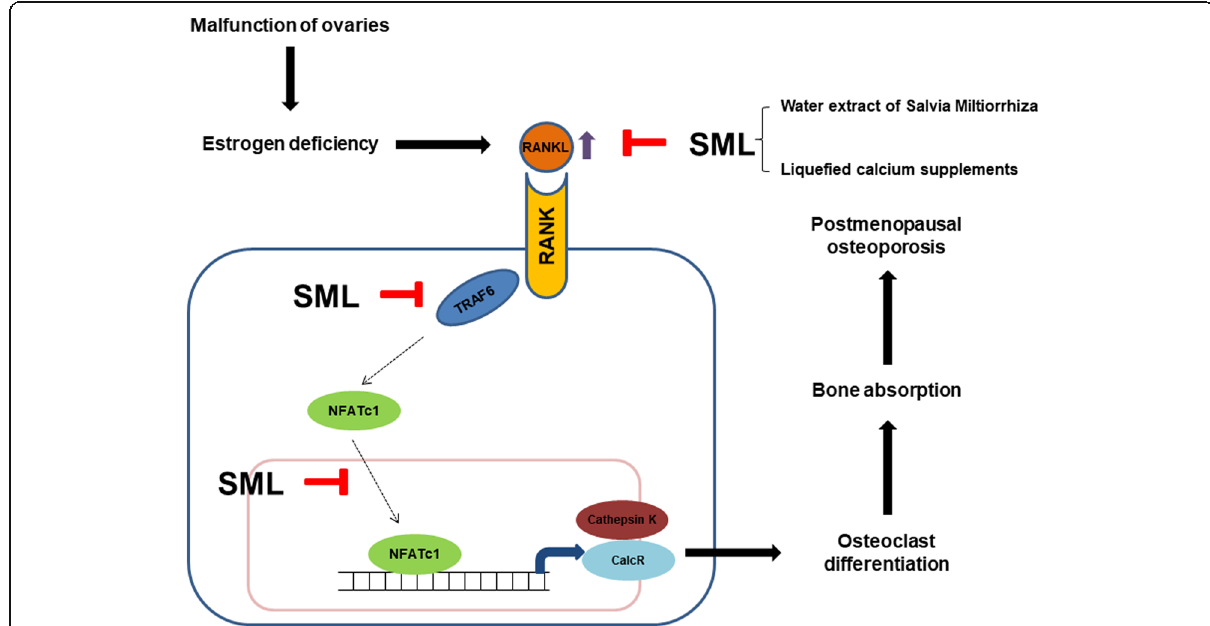
Fig. 7 Schematic diagram showing the inhibitory effects of SML on OVX-induced osteoporosis via regulation of RANK/RANKL/OPG signaling